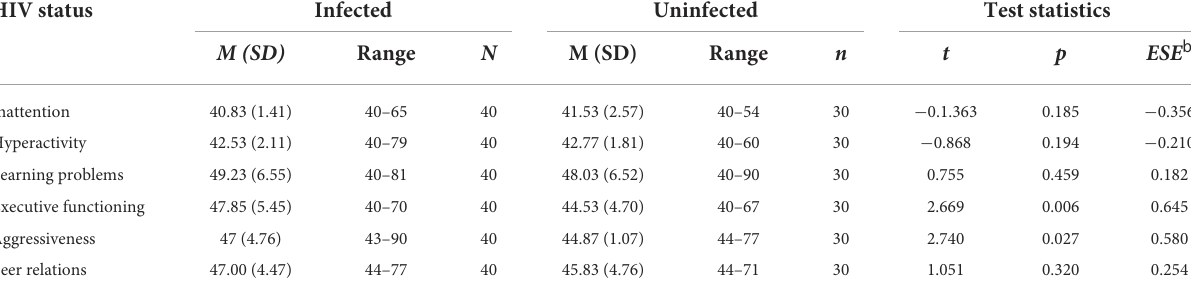
TABLE 2 Between group comparisons on Connors a .